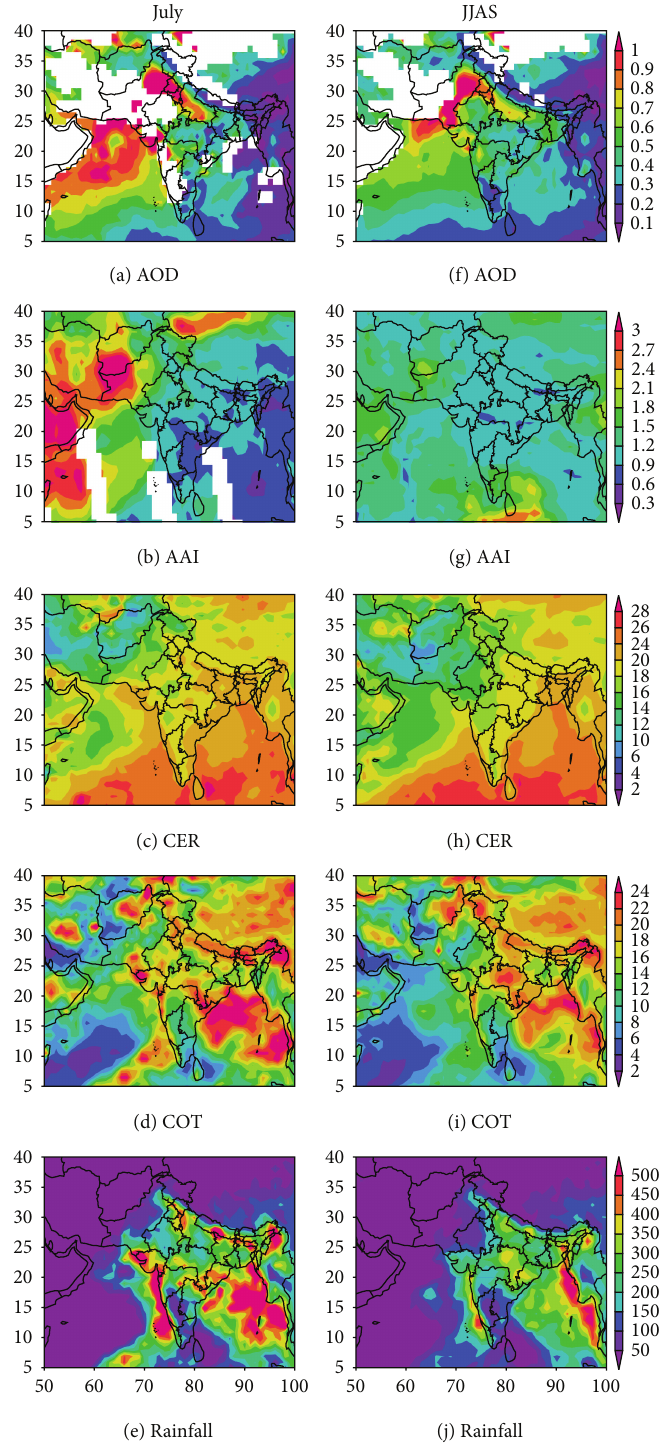
Figure 3: ((a), (f)) Aerosol optical depth (AOD), ((b), (g)) absorbing aerosol index (AAI), ((c), (h)) cloud effective radius (CER, 𝜇 m), ((d), (i)) cloud optical thickness (COT), and ((e), (j)) rainfall (mm) in July and JJAS of 2003, respectively. Aerosol, cloud characteristics, and rainfall for the year 2003 are shown as it was a normal monsoon